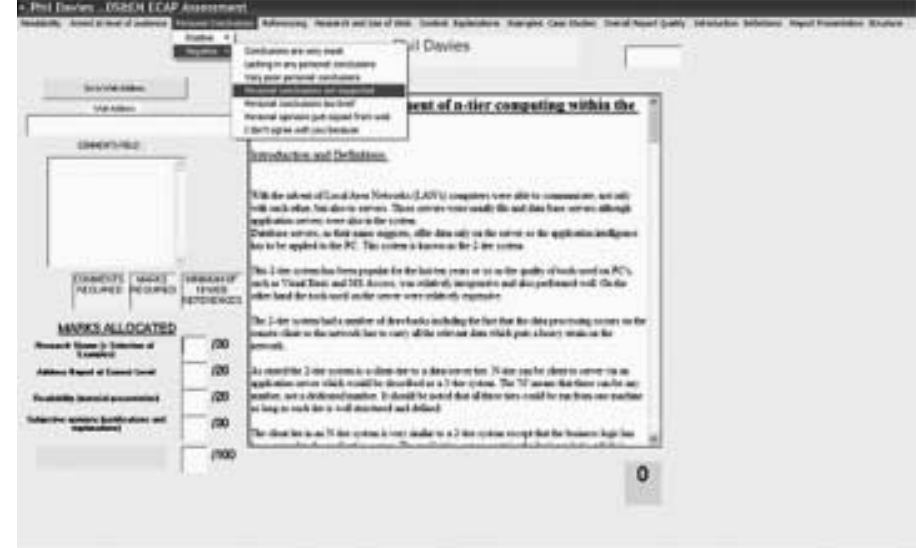
Figure 1. CAP marking via pull-down